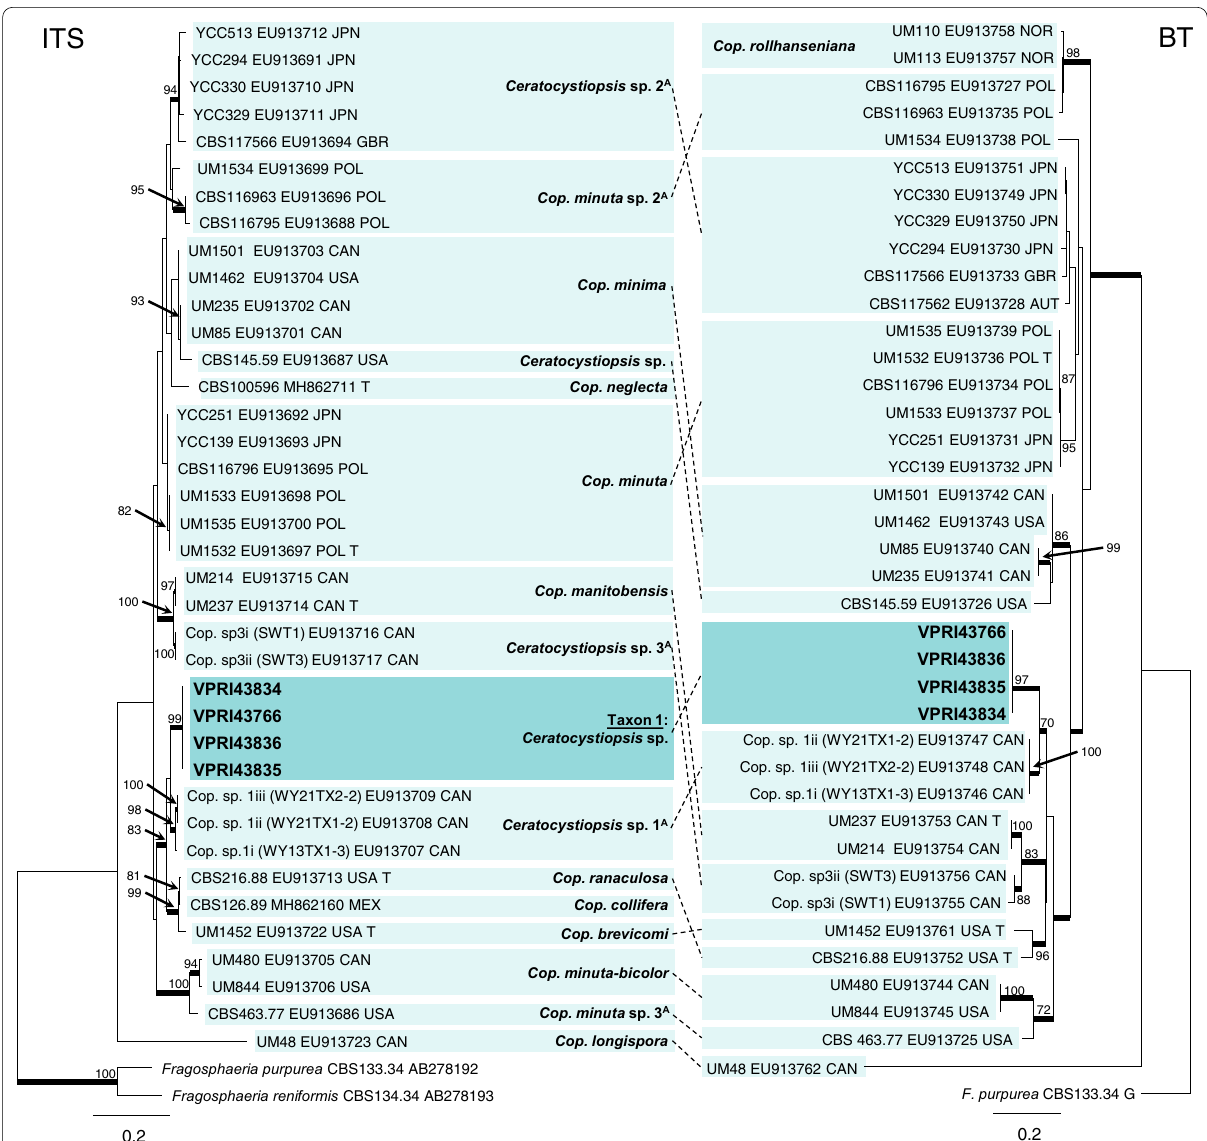
Fig. 3 Phylogenetic analysis of isolates residing in Ceratocystiopsis. Sequences generated in this study are printed in bold. Bold branches indicate posterior probability values 0.9, while ML bootstrap values of ≥ genome. A Current taxon name as described by De Beer and Wingfield